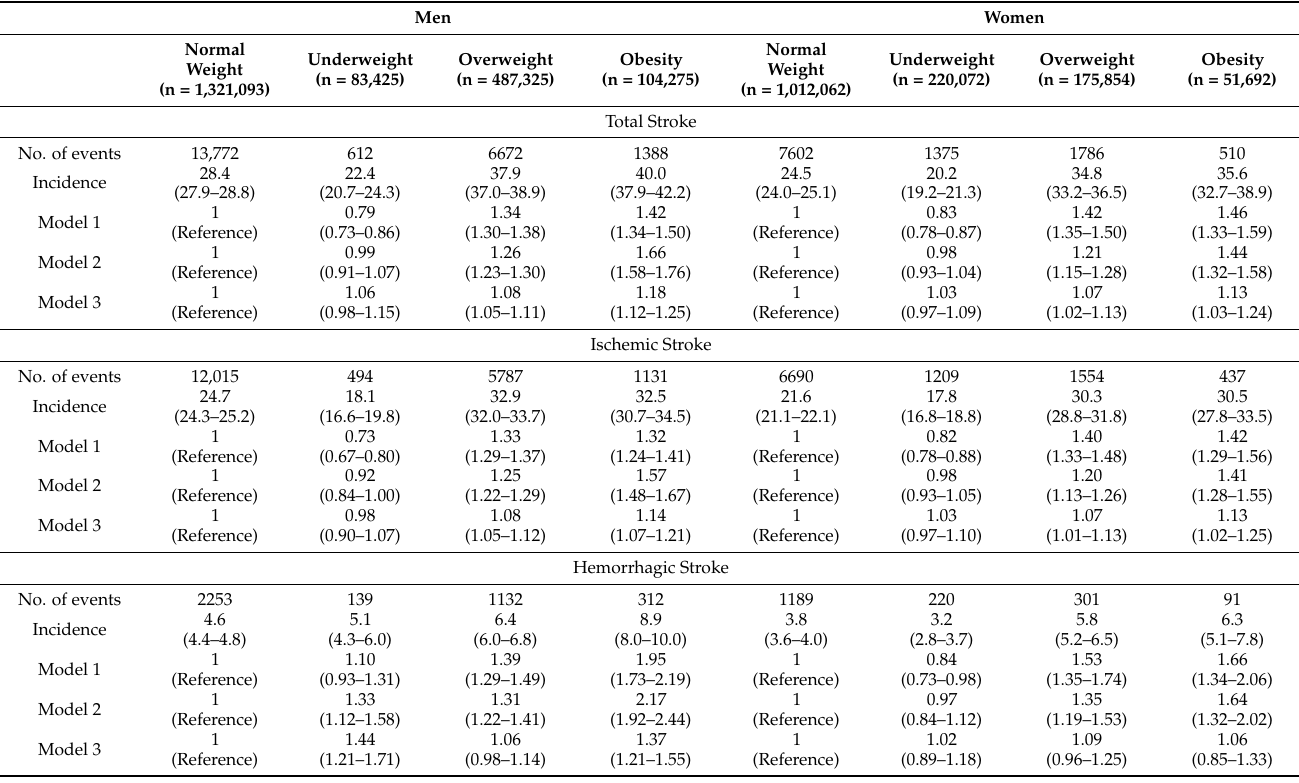
Table 3. Association between Body Mass Index Category and Stroke Events Stratified by Sex after Multiple Imputation for Missing